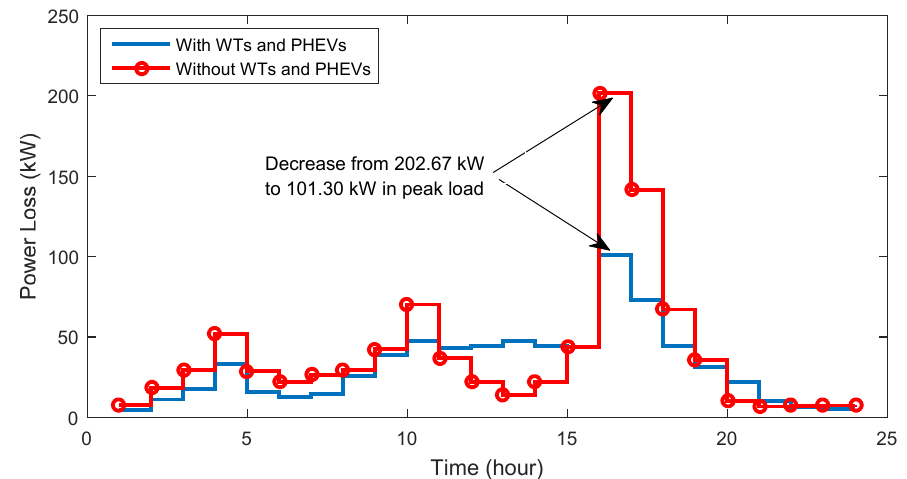
Figure 10. Power losses with and without OSPF via the AOA for 24 h.